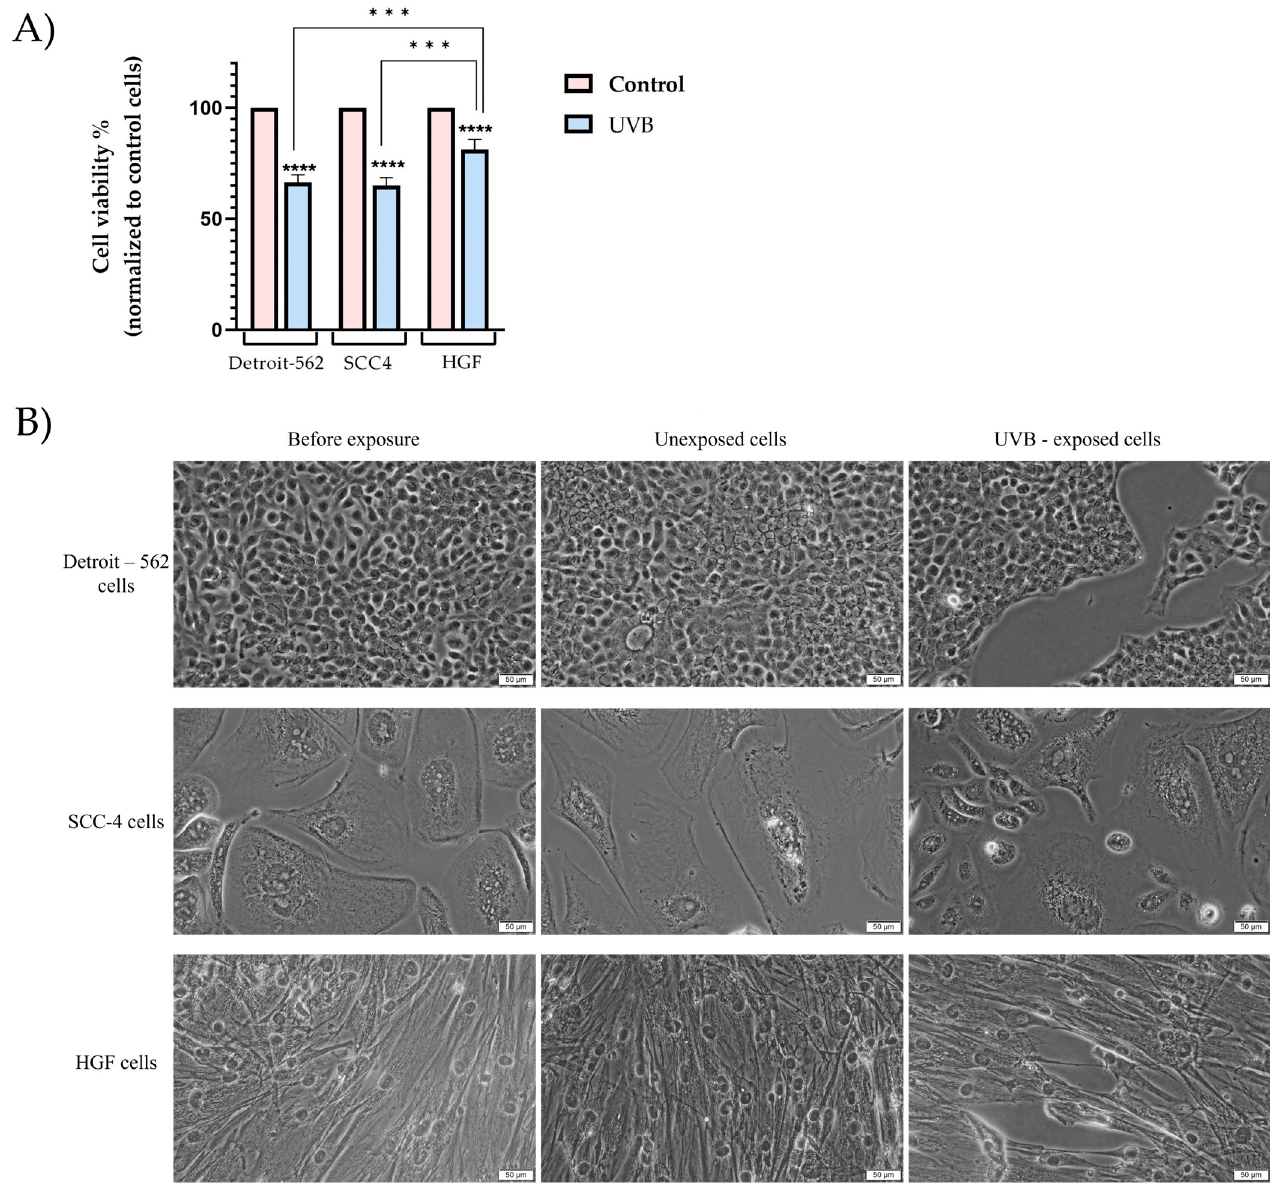
Figure 1. ( A ) In vitro assessment of the influence of UVB (2.5 J/cm 2 ) on the viability of Detroit-562, SCC4, and HGF cells. The MTT assay was performed immediately after UVB exposure. Data are presented as viability percentages (%) normalized to control (unexposed cells) and expressed as mean values ± SD in the three independent experiments performed in triplicate. The statistical differences between the control and the UV-irradiated groups were verified by applying a one-way ANOVA analysis followed by Dunnett’s multiple comparisons post hoc test, and the difference between the responses of each cell line was verified by applying a one-way ANOVA analysis followed by a Tukey’s multiple comparison post hoc test (*** p < 0.001; **** p < 0.0001); ( B ) in vitro morphological changes of Detroit-562, SCC4, and HGF cells before and after exposure to UVB. The scale bar indicates 50 µ